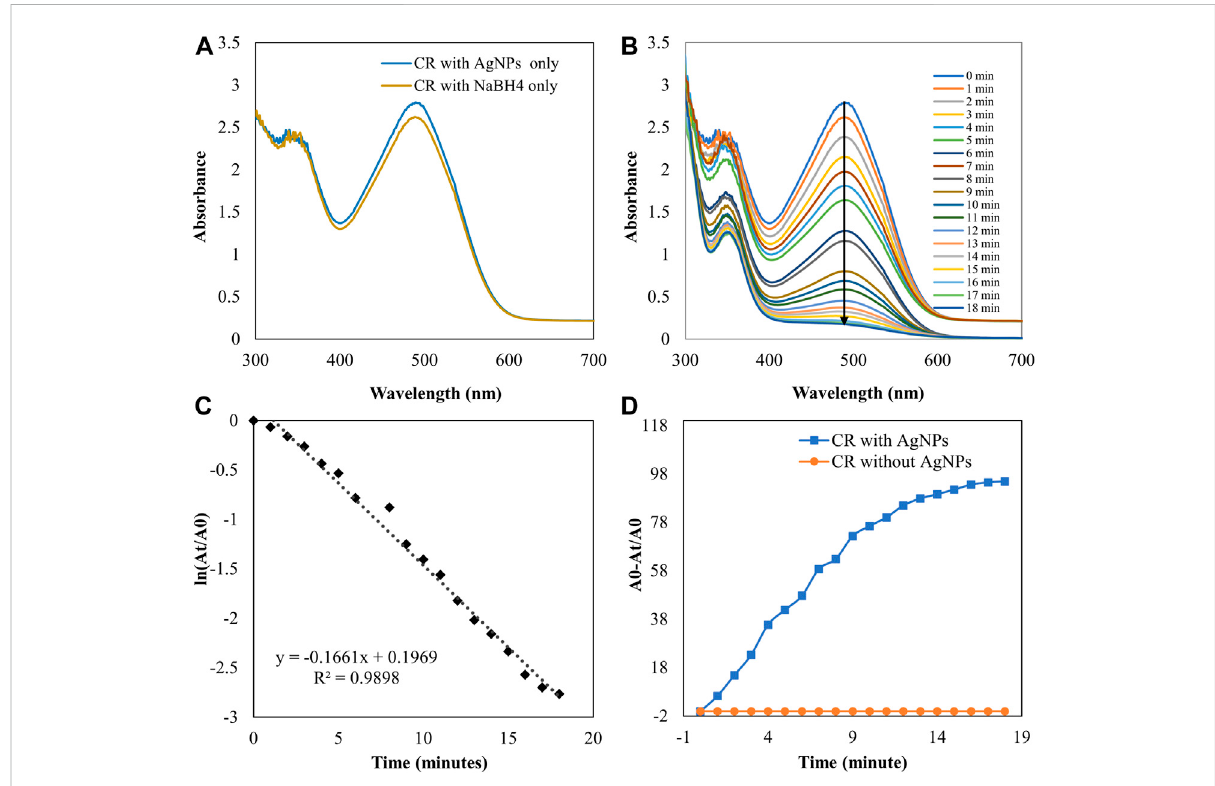
FIGURE 11 UV-visibleabsorptionspectrapf (A) CRwithAgNPsandNaBH 4 separately (B) CatalyticdegradationofCRbyNaBH 4 inthepresenceofAgNPs (C) Pseudo- fi rst order plot of the ln (A t /A 0 ) vs. time of CR (D) Percent degradation of CR with time by AgNPs.